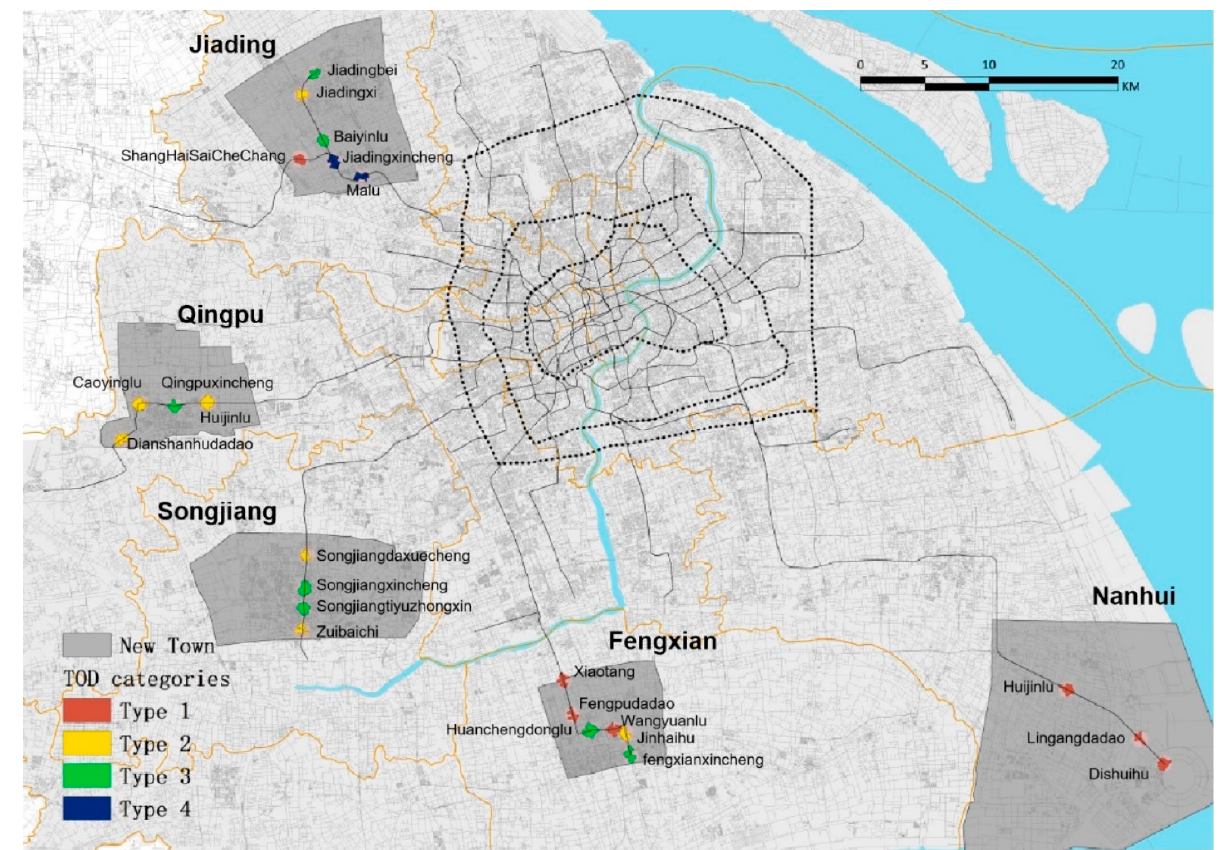
Figure 10. The spatial distribution of clustered metro stations regarding their TOD typologies.